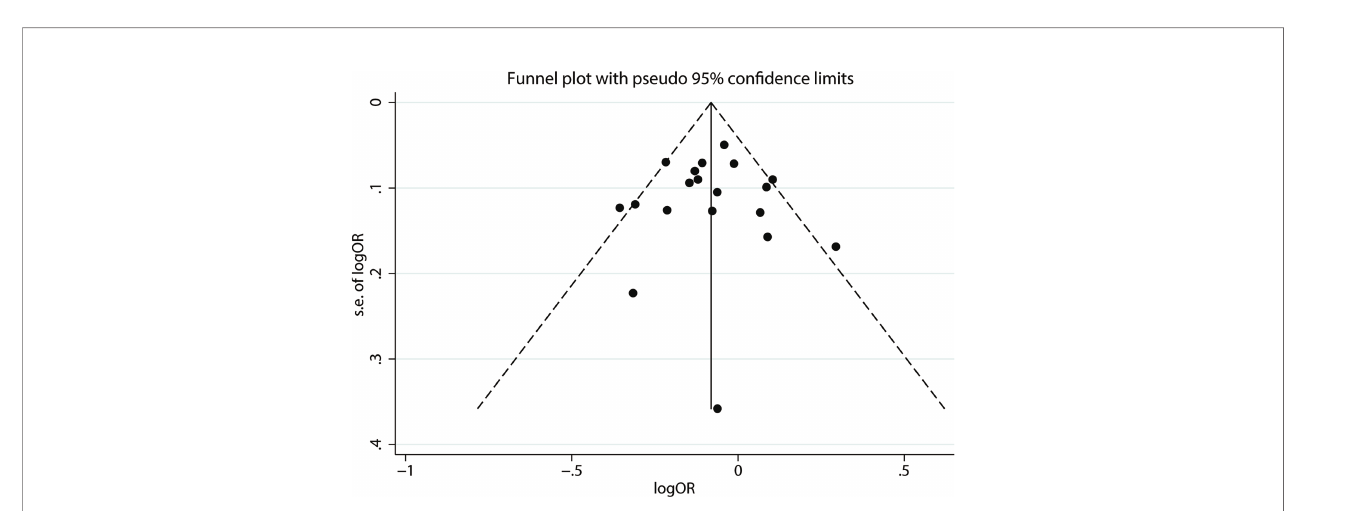
FIGURE 3 | Funnel plot of publication bias on the relationship between LEP G19A polymorphism and the risk of digestion-related cancer in allele model (A vs.